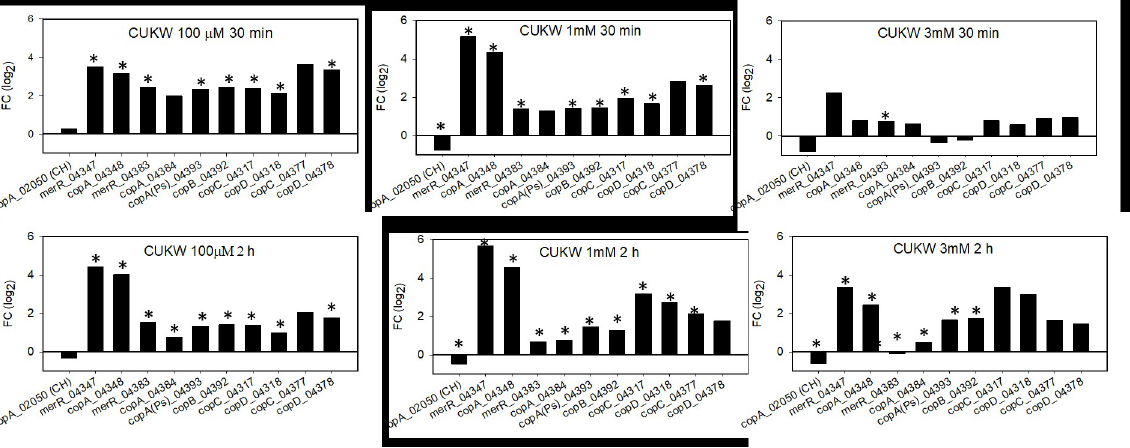
Fig 5. CUKW expression profiling with subset of copper-associated homologs from E . coli Cue and Pseudomonas Cop systems under a range of copper concentrations. Overnight cultures were diluted 1:100 into Burkholder’s B medium and incubated for 6 h, whereupon copper was added to final concentrations of 100 μ M, 1mM, and 3mM. Samples were collected at 30 min and 2 h for expression profiling. copA(Ps) = designates copA of P . syringae system, of which copB , C , and D also belong. CH indicates gene is located on the CUKW chromosome. Gene expression was calculated using the ΔΔ C T method, with expression normalized to the reference gene pfk . Fold-change presented as log 2 - transformed values. � indicates significant difference between treatment (100 μ M, 1 mM, or 3 mM copper, as designated in each panel) and control (no copper) at 30 min and 2 h (p <